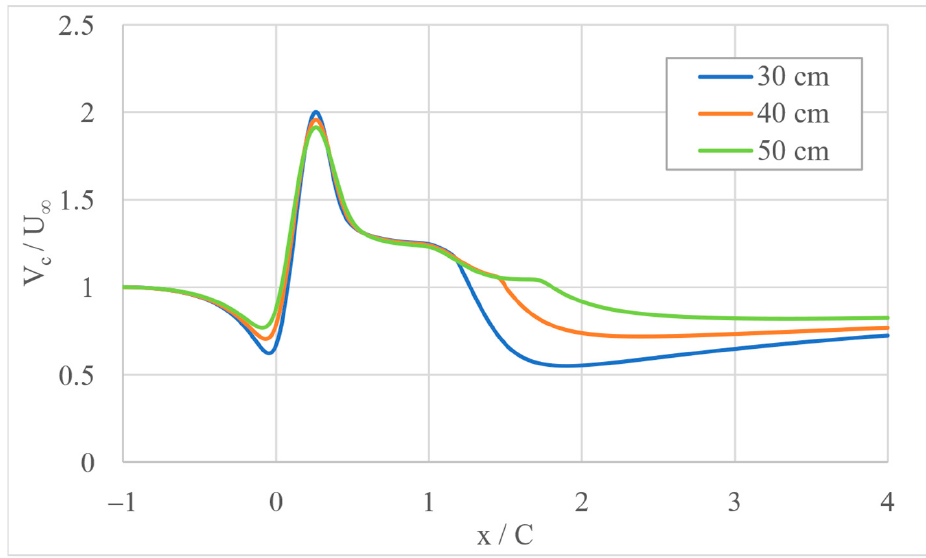
Figure 10. Center line velocity change along the augmentation system with different gaps ( U ∞ = 3 m/s, +5° pitch angle).